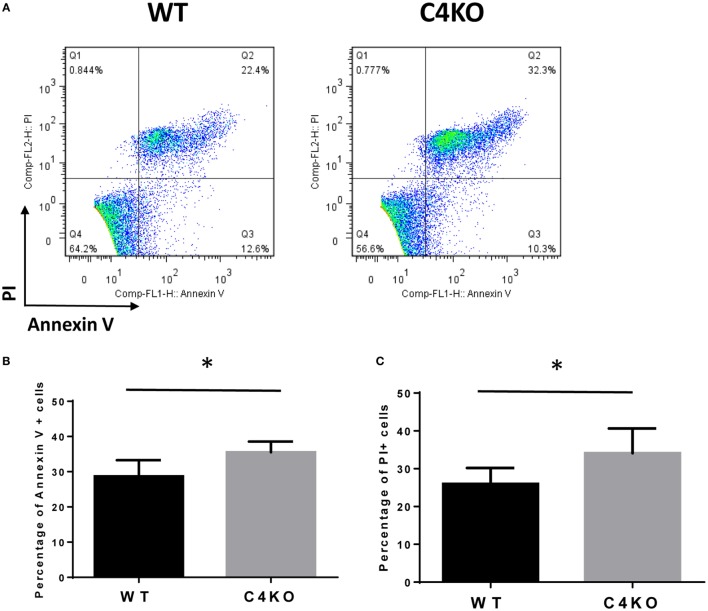
Effect of C4 deficiency on the survival of activated T cells. CD4+ T cells purified from naïve wild-type (WT) and C4 KO mice were incubated with anti-CD3 and anti-CD28 mAbs for 48 h, then the percentage of apoptotic or dead T cells was assessed, respectively, by Annexin V or PI staining, followed by flow cytometric analysis. (A) Representative results; (B,C) summarized results from three independent experiments. Mean ± SEM. *p < 0.05 by paired t-test.